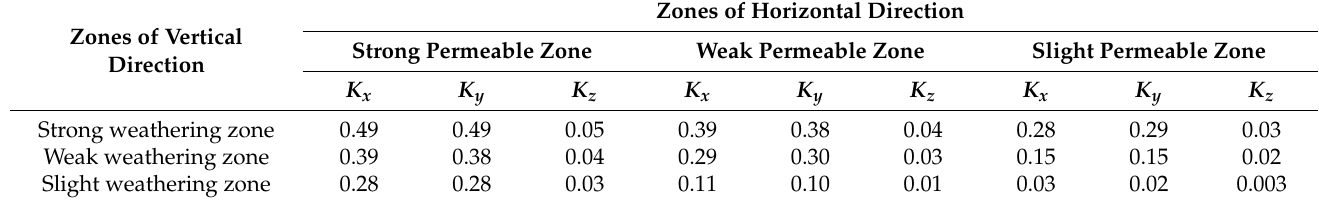
Figure 7. Calculated and measured values of groundwater levels.